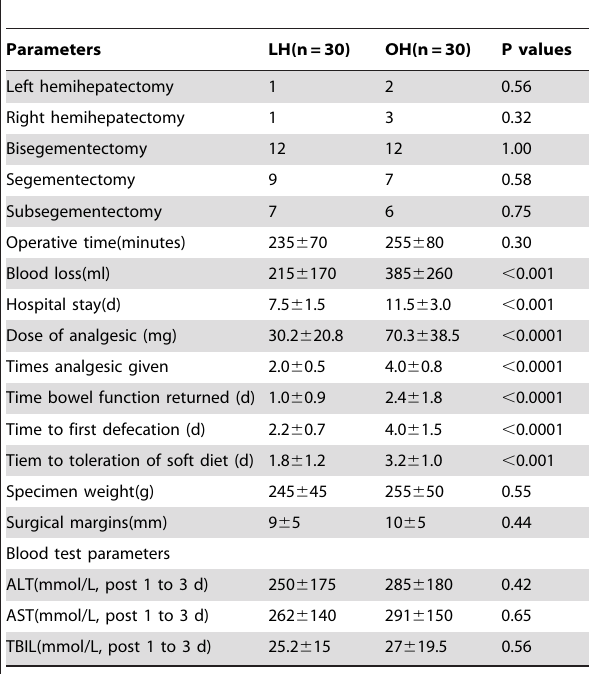
Table 3. Operative findings and postoperative laboratory test for matched